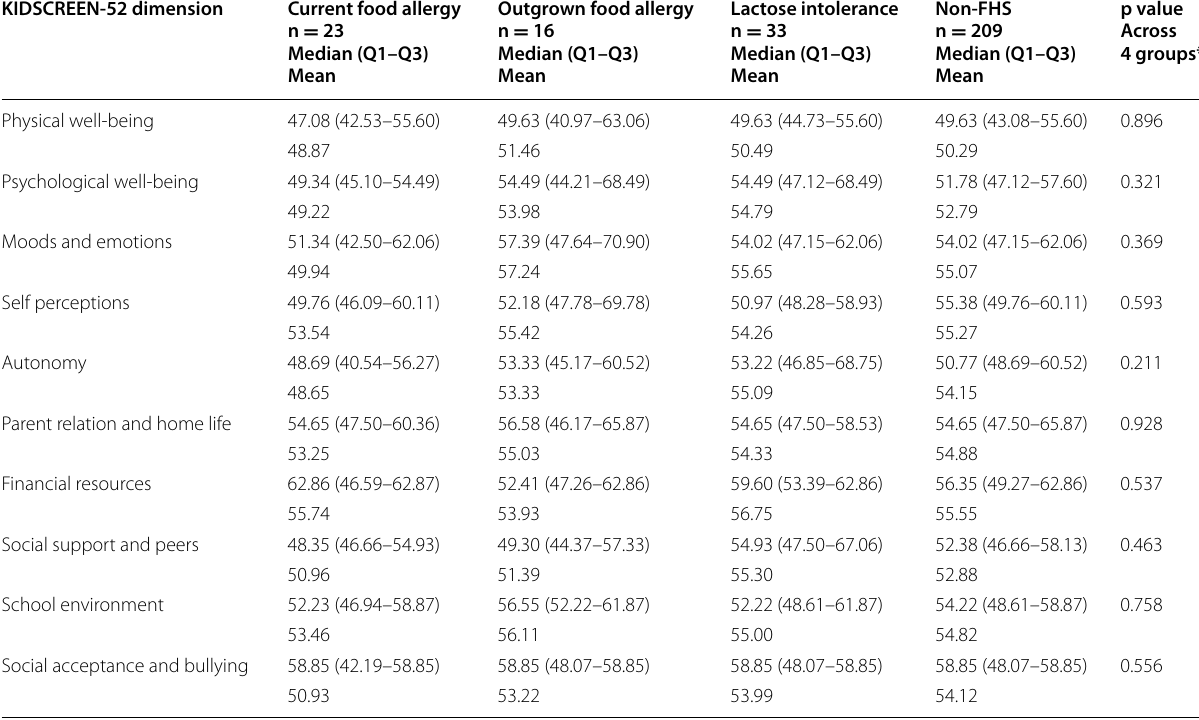
Table 3 Scores in KIDSCREEN-52 domains among children with different food hypersensitivity phenotypes and children without food